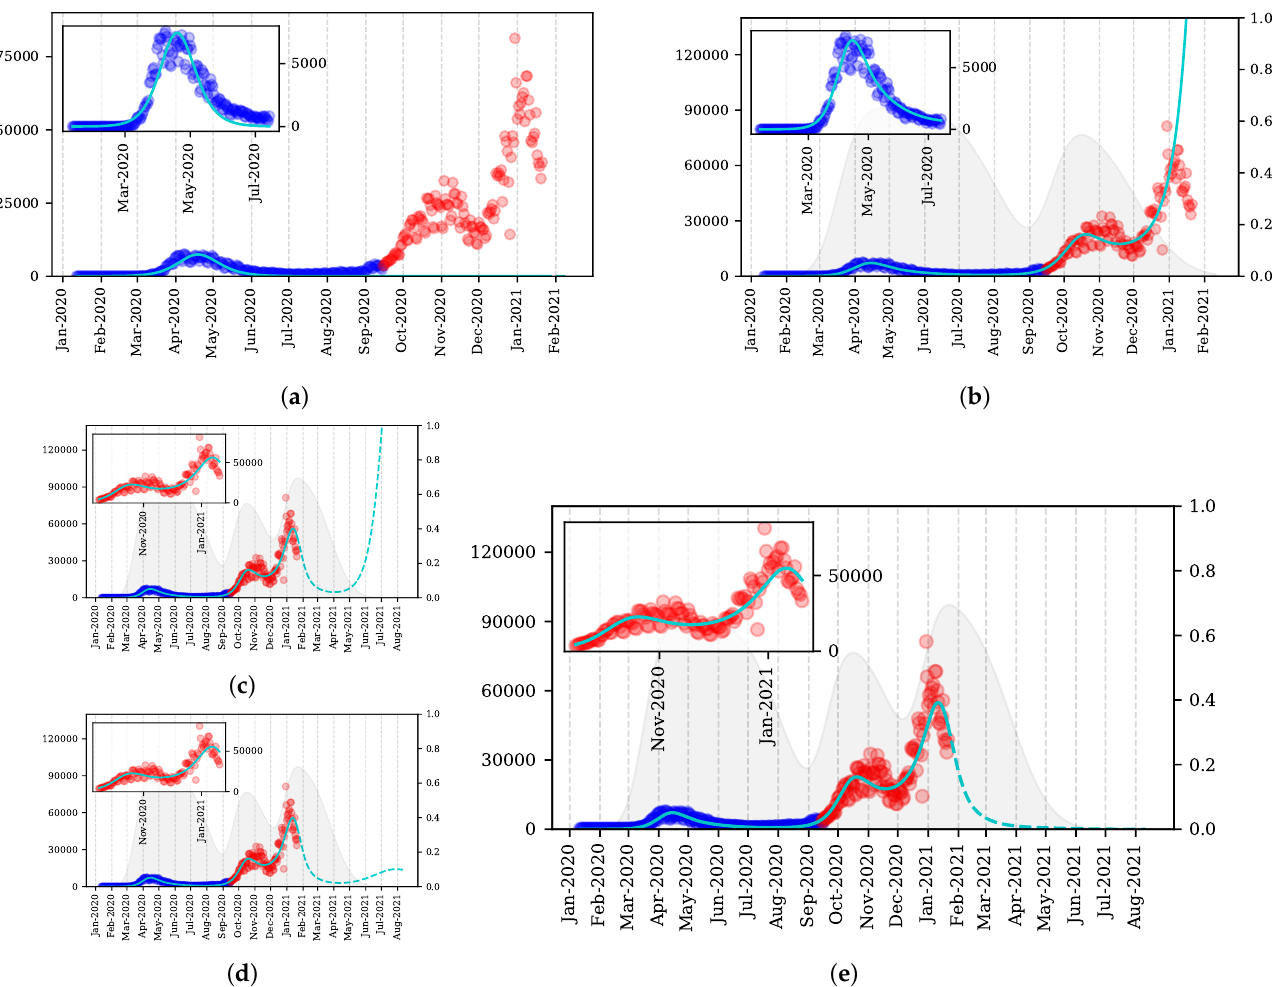
Figure 2. SARS-CoV-2 new daily cases (left axis): blue circles for first-wave data used to fit free and controlled SIR models (light-blue lines), red circles for second- and third-wave data used to test the models and their predictions (light-blue dashed lines). ( a ) Free SIR model captures the essence of the time evolution of new CoVid-19 cases over March–July 2020 (inset plot), but totally fails to predict the second and third waves. ( b ) The controlled SIR model without vaccination fits better to first-wave data (inset plot) than the free version. The grey area represents the effectiveness of preventive measures, A ( t ) (right axis). The first wave of social awareness is fit together with β and α , showing a maximum of effectiveness η 1 (cid:39) 65%, social inertia δ i (cid:39) 21d, and social relaxation starting at mid June 2020, with prediction of no measures in δ r (cid:39) 45d after relaxation begins. The second wave of social awareness begins in September (confirmed by the Prime Minister[10]), reaching η 2 (cid:39) 60% by mid October 2020 (three-tier system was introduced[11]). The upsurge of CoVid-19 cases in December 2020 is again a consequence of social relaxation. ( c – e ) Controlled SIR model with vaccination rates: 0.1%d − 1 , 0.2%d − 1 , and 0.4%d − 1 , respectively, along with a third-wave of preventive measures (expected to reach maximum effectiveness, η 3 = 70%, by the mid January 2021). To avoid a fourth wave, the vaccination campaign would need to deliver ∼ 200 × 10 3 vaccines per day ( ∼ 0.4% N /d) as of the first week of January